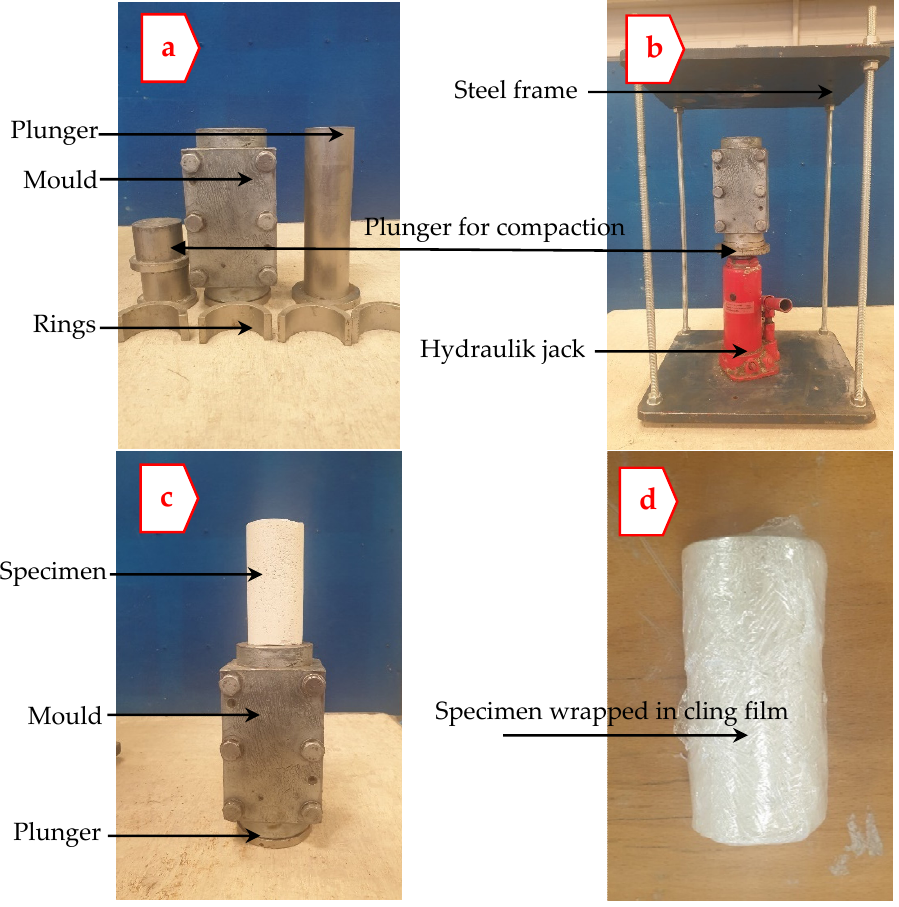
Figure 3. Apparatus used for specimen preparation, ( a ) steel mould to accommodate the semi-paste mixture, ( b ) steel frame and hydraulic jack for specimen compaction, ( c ) extruded specimen and ( d ) extruded specimen wrapped in cling film.